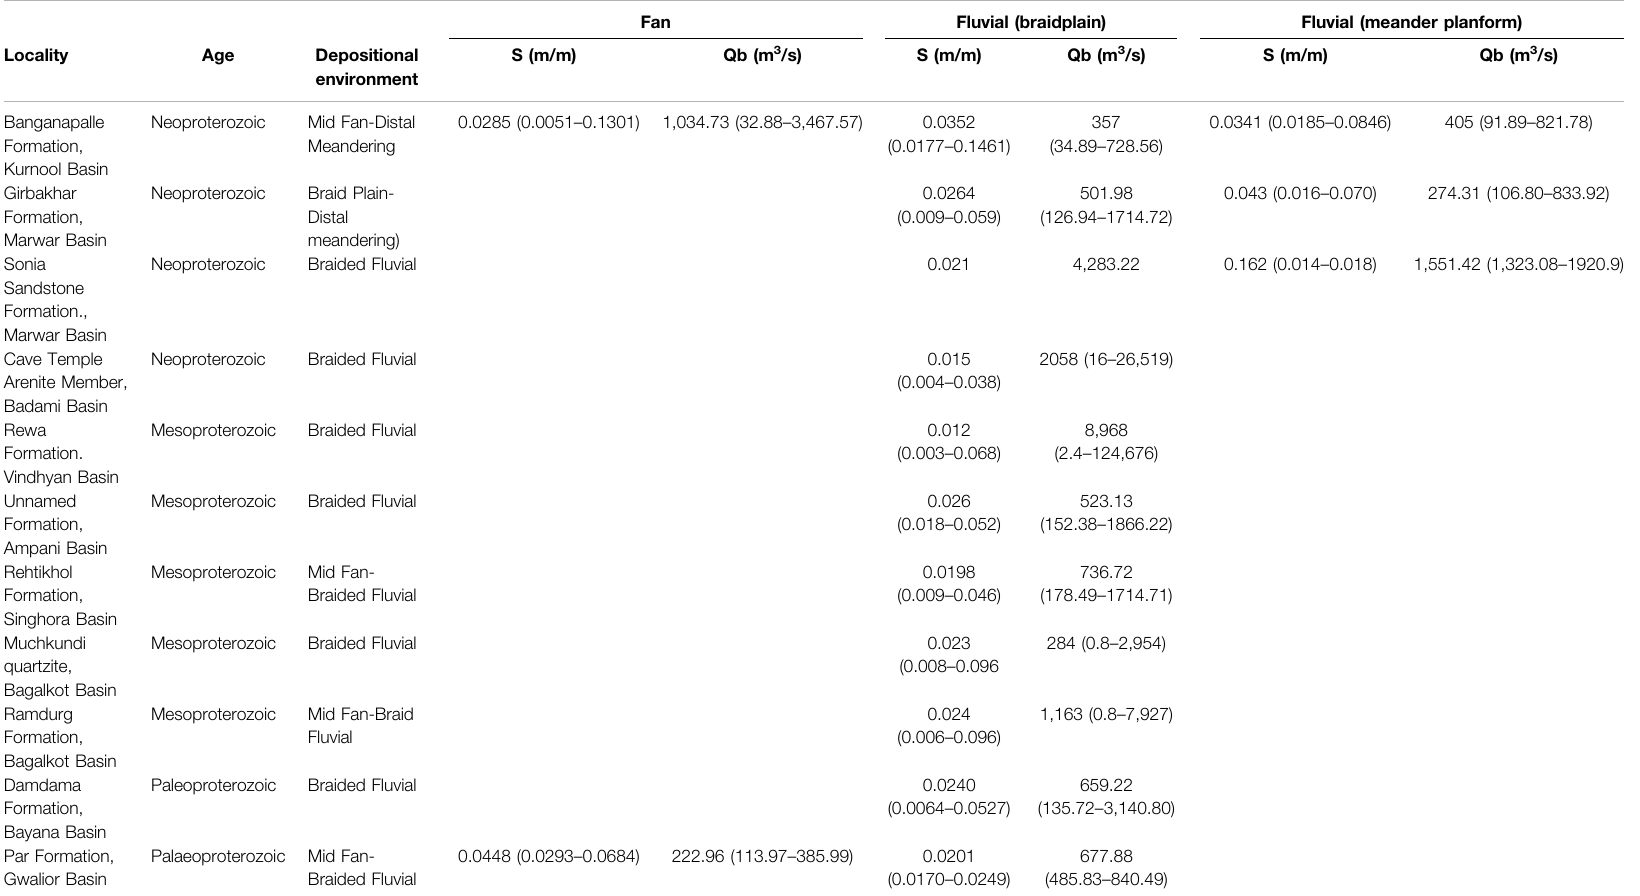
TABLE 2 | Alluvial deposits from Indian Precambrian basins, their geological ages, interpreted depositional settings viz. fan, braided fl uvial, distal meandering fl uvial, and deduced paleohydraulic parameters (slope and